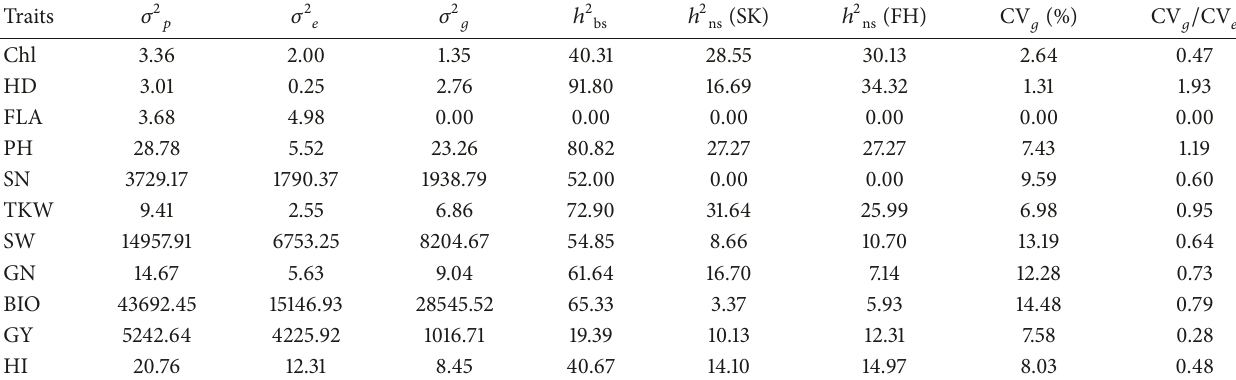
Table 3: Genetic and nongenetic parameters of different bread wheat traits